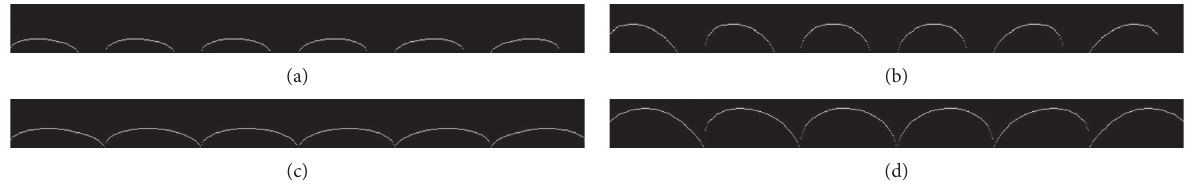
Figure 3: Typical template elliptical arcs with different parameters. (a) r s j � 0.8, and c k � − 0.5, − 0.3, − 0.1, 0.1, 0.3, and 0.5. (c) r i � 60, s j � 0.4, and c k �− 0.5, − 0.3, − 0.1, 0.1, 0.3, and 0.5. (d) r i � 60, s j � 0.8, and c k �− 0.5, − 0.3, − 0.1, 0.1, 0.3, and